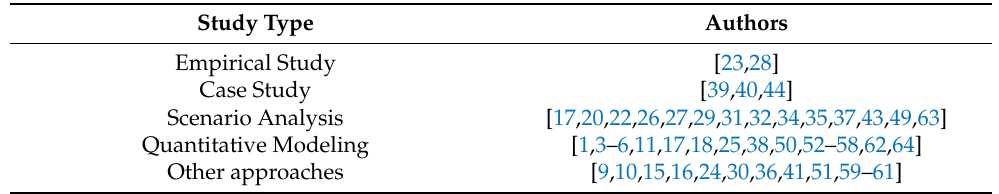
Table 2. References of literature for different approaches.